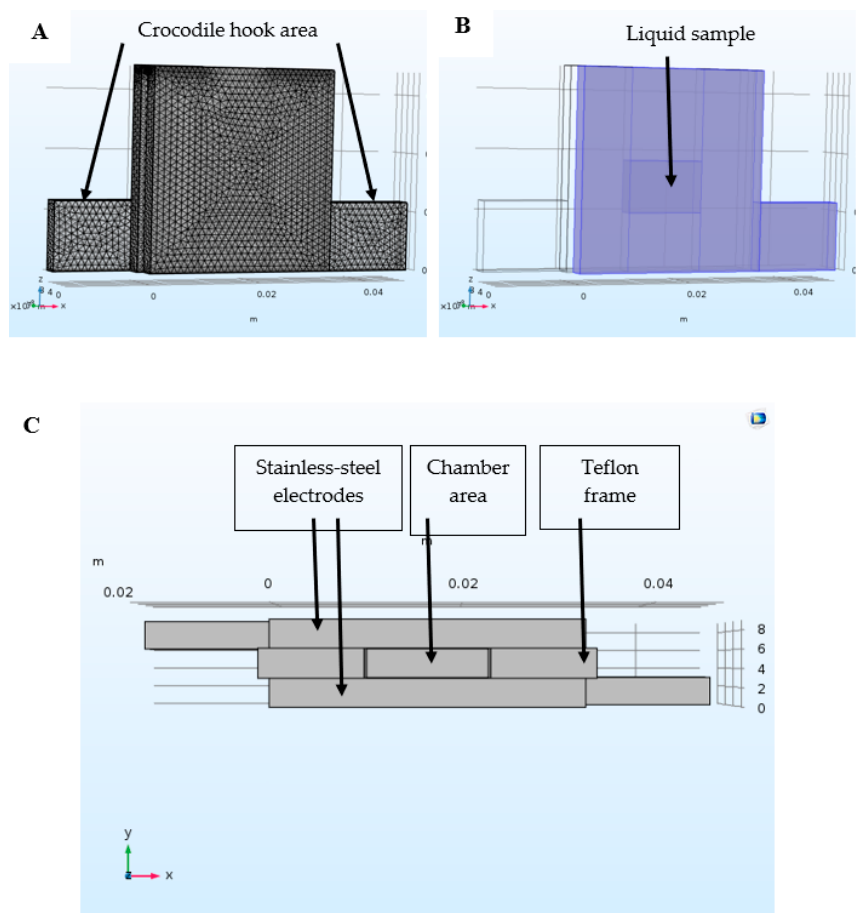
Figure 1. Schematic drawing of the electroporator chamber: Side view ( A , B ); top view ( C ).